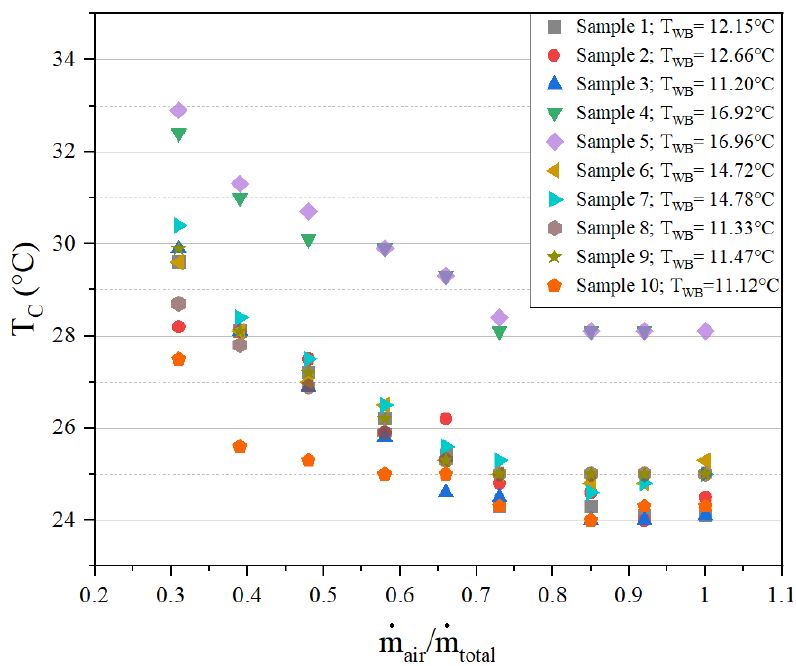
Figure 4. Variation of condensation temperature as a function of the mass flow rate of air.